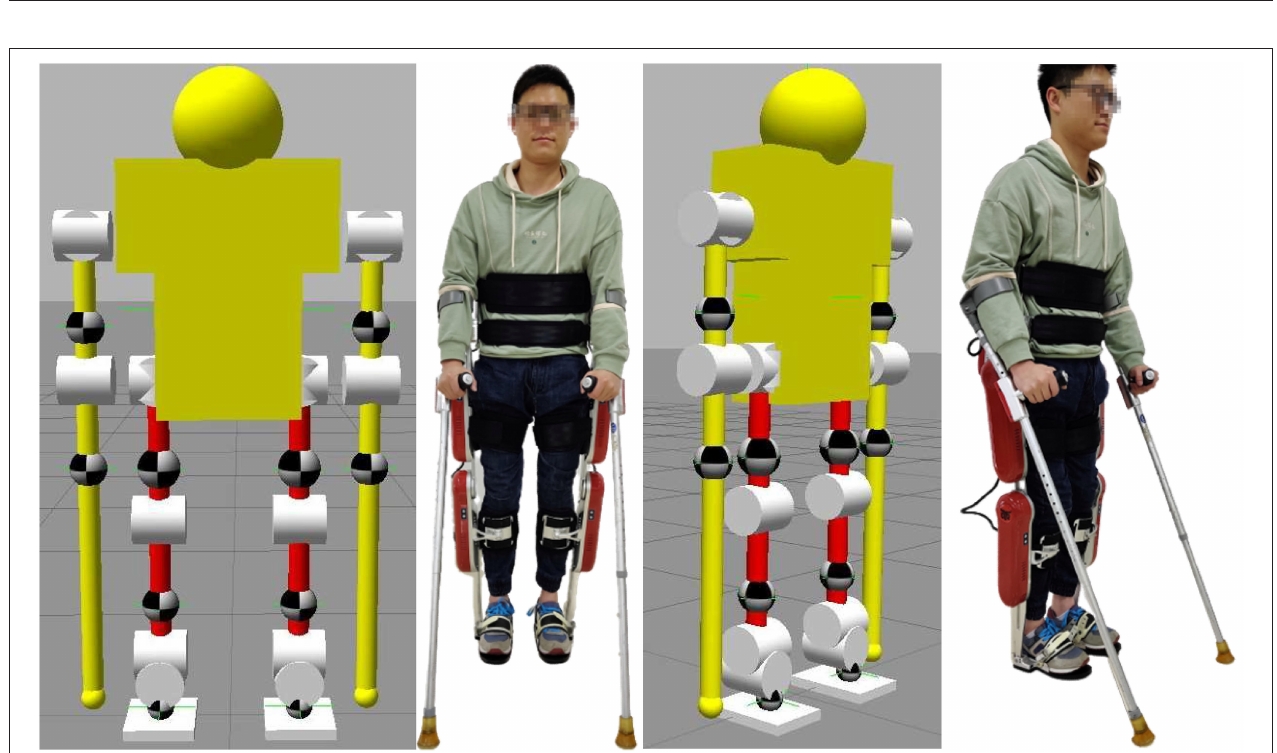
FIGURE 6 | The front and side of the human-exoskeleton model. This human-exoskeleton model has 10 active joints and 16 active degree of freedoms (DoFs), namely the left and right shoulder, wrist, hip, knee and ankle joints. In addition, the shoulder, hip and ankle joints on the left and right have two active DoFs, while the others only have